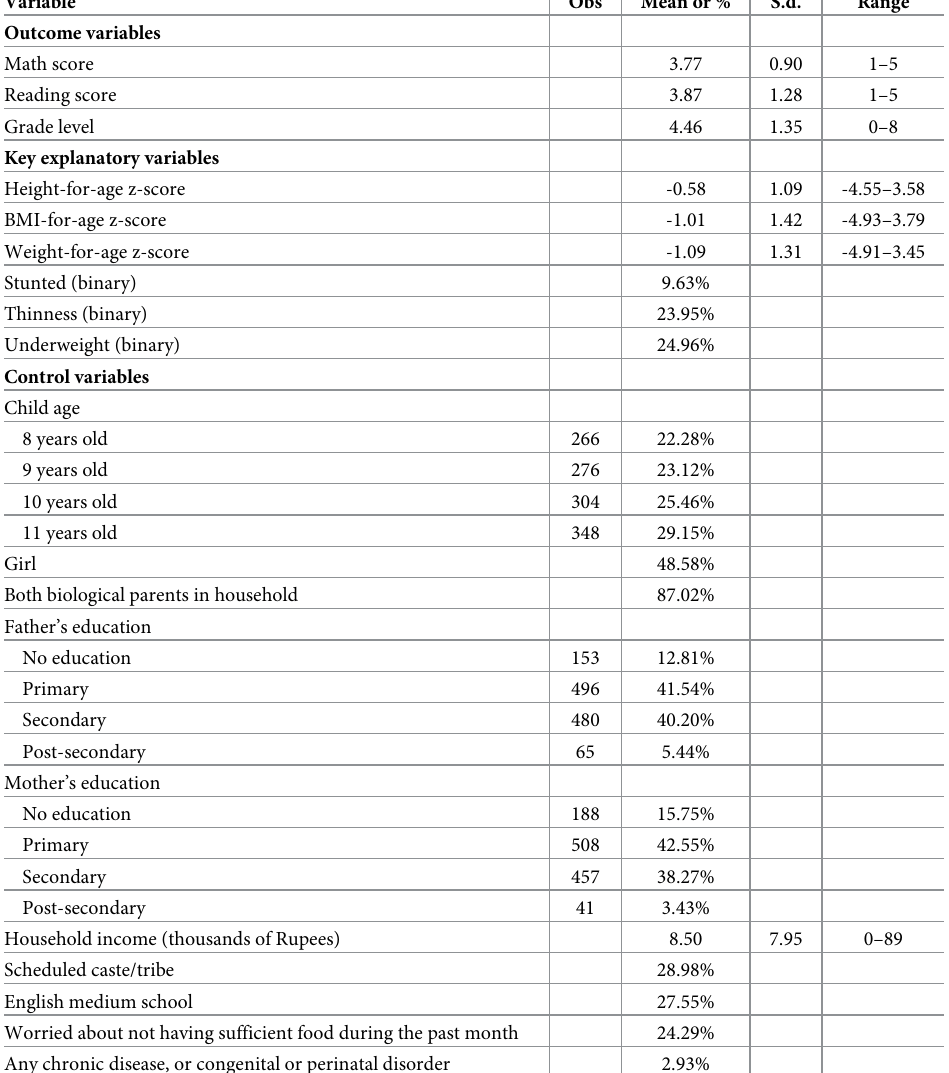
Table 1. Children aged 8–11 outcome measures, anthropometrics, and socio-demographic characteristics (N =